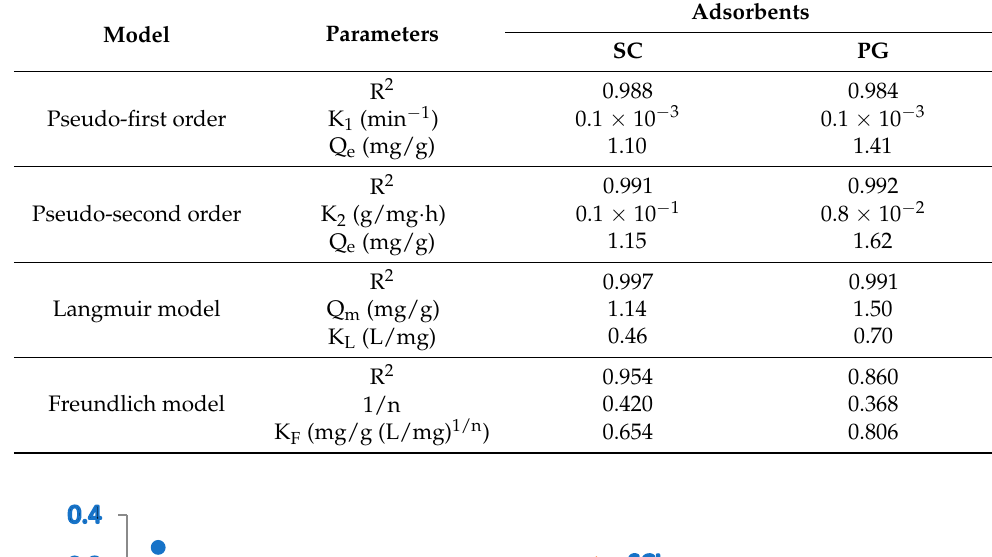
Table 7. The fitted parameters obtained from adsorption kinetics and isotherm models. Model